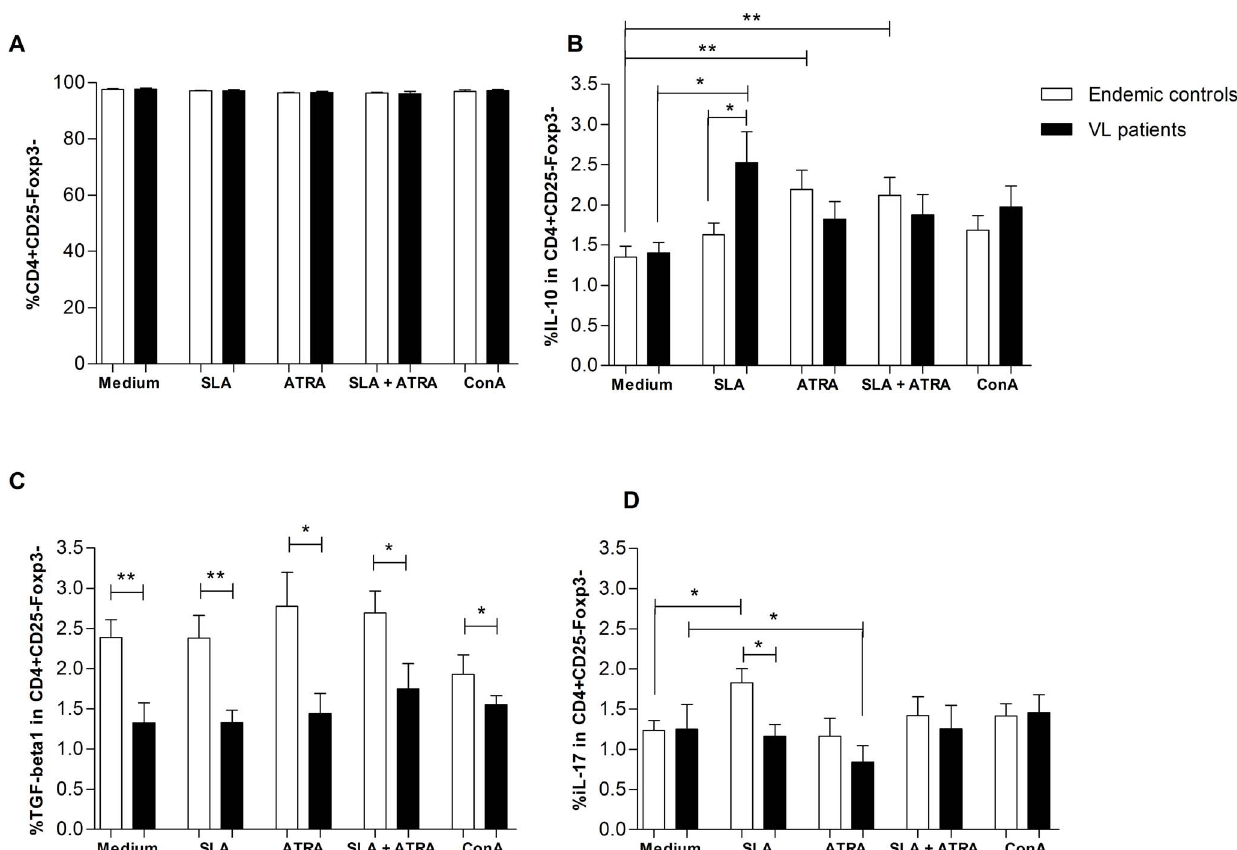
Figure 4. Cytokines expression in of CD4 + CD25 2 Foxp3 2 response to different stimuli. A . Similar frequency of CD4 + CD25 2 Foxp3 2 T cells in studied groups and conditions. B . IL-10 production in CD4 + CD25 2 Foxp3 2 T cells after tested conditions. C .TGF- b 1 production in CD4 + CD25 2 Foxp3 2 T cells after tested conditions. D . IL-17 production in CD4 + CD25 2 Foxp3 2 T cells after tested conditions. Subjects tested, endemic controls (n=16) and VL patients (n=10). Mann-Whitney test was used to compare endemic controls to VL patients. Wilcoxon matched pairs test was used to compare cultures stimulated and non-stimulated within the studied groups. * p , 0.05; ** p , 0.01. Bars represent median and IQR. ATRA = all-trans retinoic acid. SLA = Soluble Leishmania antigens (SLA). ConA = Concanavalin